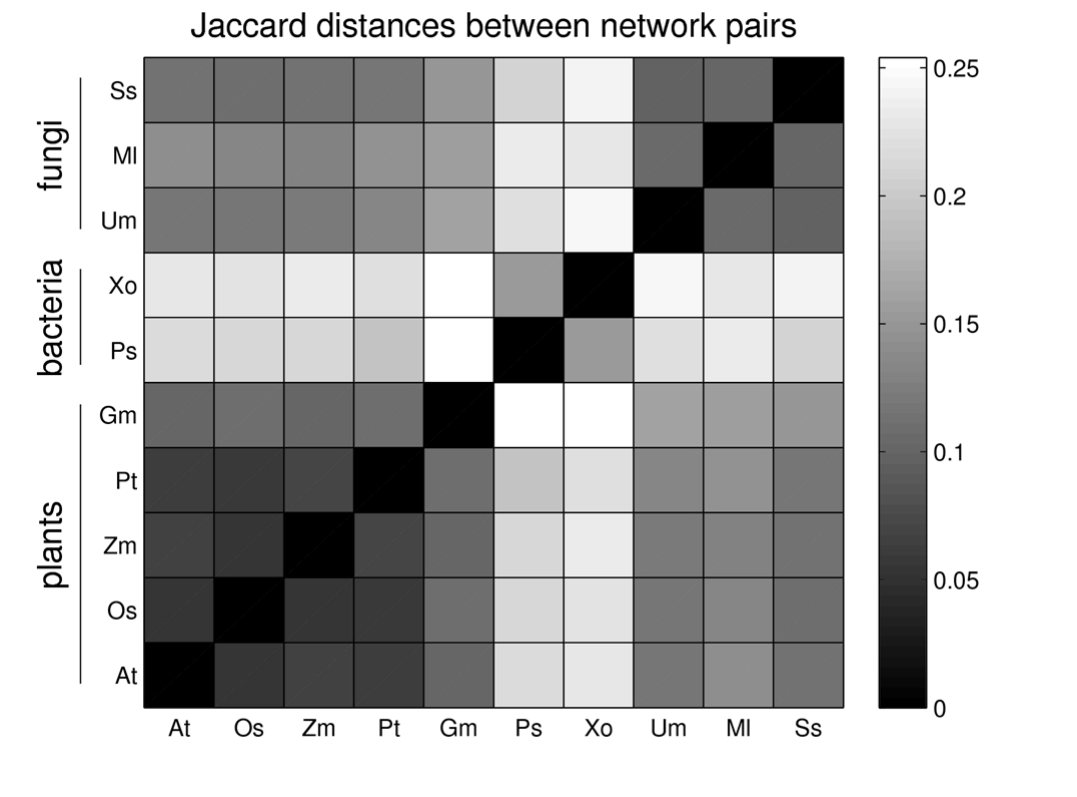
Figure 2. Pairwise network-network overlap based on the Jaccard distance for present metabolic reactions in the 5 plant and 5 phytopathogen genomes investigated in this study. The values of the respective Jaccard indexes are visualized by